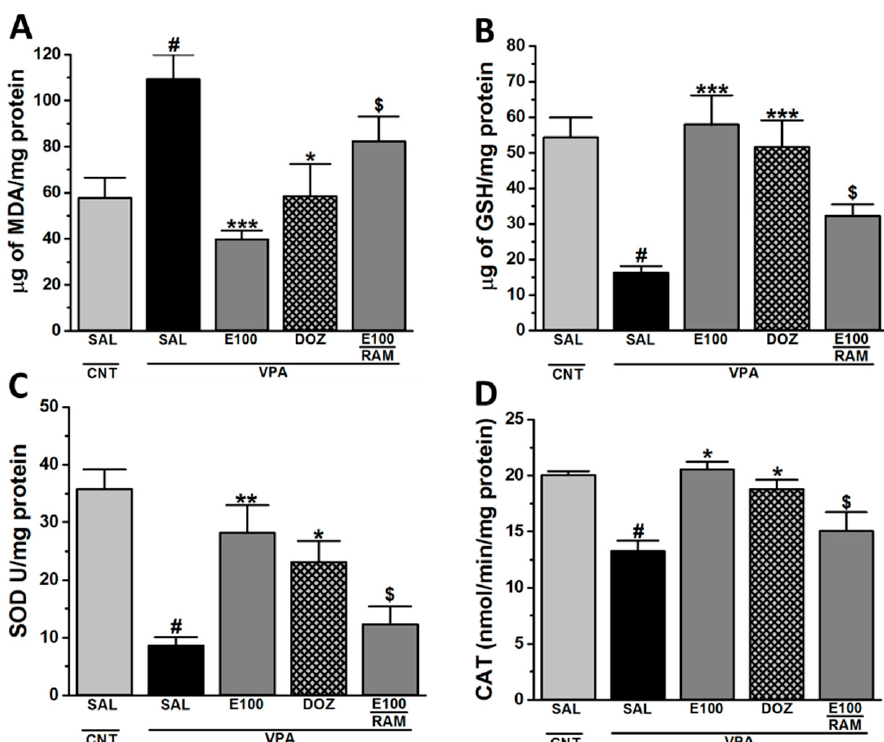
Figure 4. E100 restored levels of oxidative stress markers in the cerebellum. Modulated malondialdehyde (MDA), glutathione (GSH), catalase (CAT), and superoxide dismutase (SOD) were assessed. VPA mice showed a significant increase in MDA ( A ) and significant decrease in GSH ( B ), SOD ( C ), and CAT ( D ) compared to CNT mice. Subchronic systemic administration of E100 (10 mg/kg) or DOZ (1 mg/kg) were assessed in VPA mice. E100 (10 mg/kg) or DOZ (1 mg/kg) significantly reduced the increased levels of MDA ( A ) and significantly increased the reduced levels of GSH, SOD and CAT ( A – D ). Abrogative effects of subchronic (21 days) systemic co-administration with RAM (10 mg/kg) on modulation of oxidative stress levels provided by E100 (10 mg) were assessed ( A – D ). Data are expressed as the mean ± SEM (n = 5). # p < 0.05 vs. VPA mice. * p < 0.05 vs. VPA mice. ** p < 0.01 vs. VPA mice. *** p < 0.001 vs. VPA mice. $ p < 0.01 vs. E100 (10 mg)-treated VPA mice. In biochemical